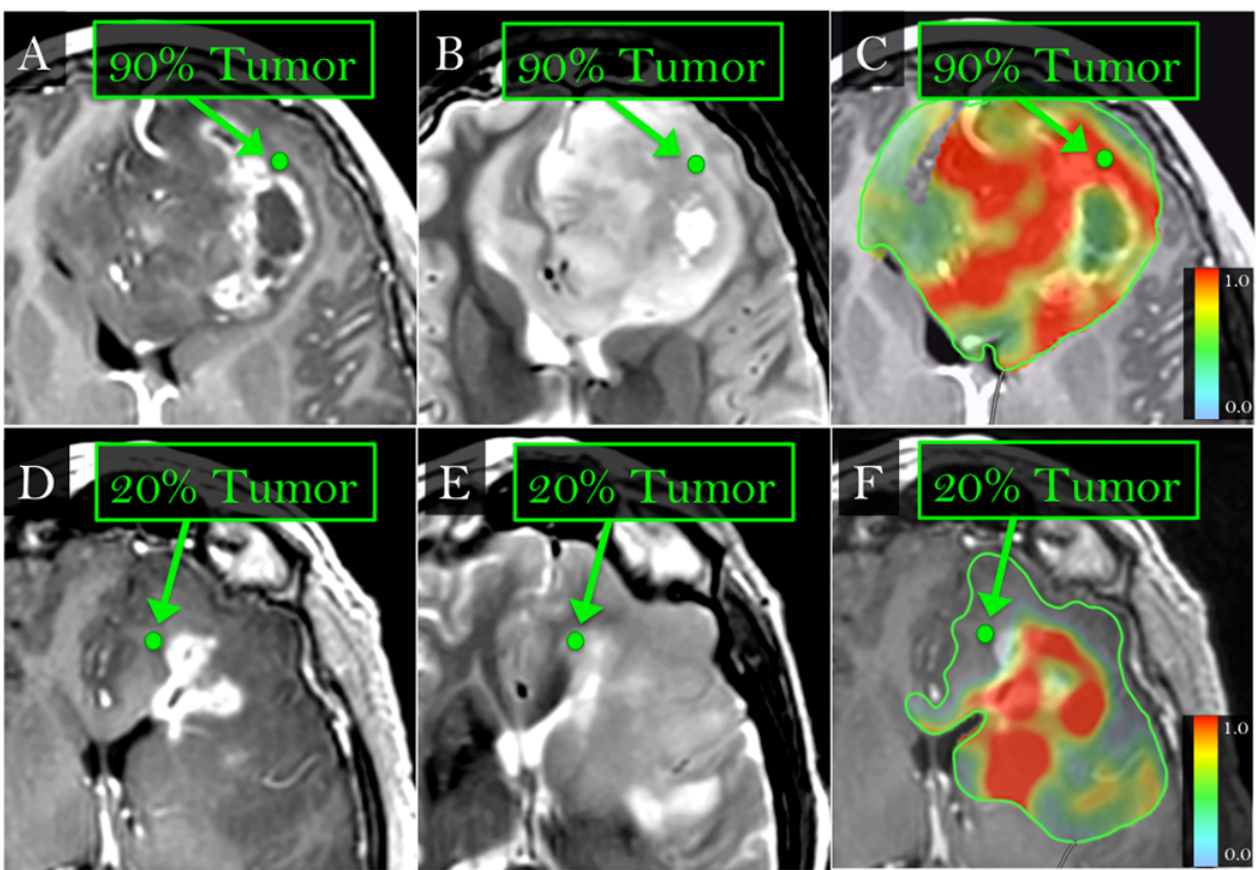
Fig 1. ML-based MRI invasion maps show tumor-rich ( > 80% tumor nuclei) extent throughout ENH and BAT. (A,B,C,E) Biopsy locations within the non-enhancing BAT zone (green dots, arrows) on T1+C (A,D) and T2W (B,E) images correspond with high-tumor ( > 80% tumor nuclei) and low-tumor ( < 80% tumor nuclei) tissue samples on histologic analysis. (C,F) Color overlay maps with manual tracings (green) around BAT show the probability (range 0 – 1) of tumor-rich (red) vs tumor-poor (green/blue) content, based on ML analysis and multi-parametric MRI in 60 training biopsies and 22 validation biopsies. The maps show correspondence between tumor-rich (B, red) and tumor-poor (D, blue/gray) biopsy samples.